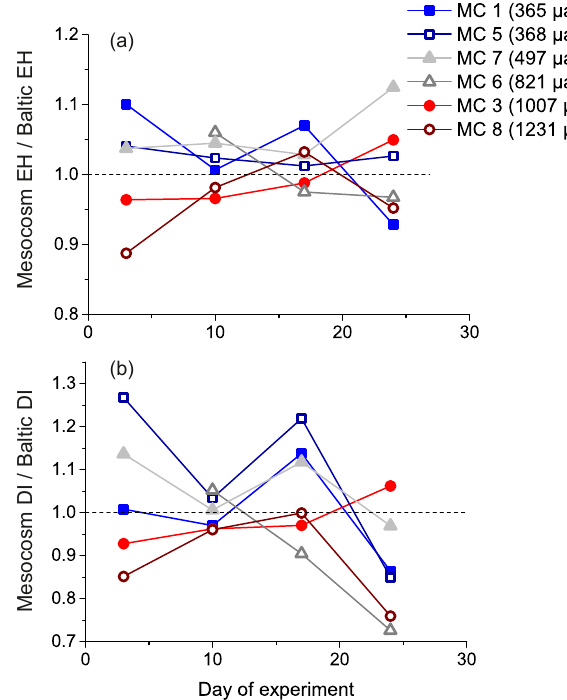
Figure 2. Development of the ratio of (a) EH mesocosm / EH Baltic and (b) nauplii development index (DI) mesocosm / DI Baltic dur- ing the study. Ratio>1: higher EH or DI in the mesocosm water (maternal environment) than in the Baltic Sea water, ratio<1: lower EH or DI in the mesocosm water (maternal environment) than in the Baltic Sea water. Note that because of different development times, the DI values are not comparable between the days. The f CO 2 (µatm) values represent the average in days 1–43 (Paul et al., 2015).